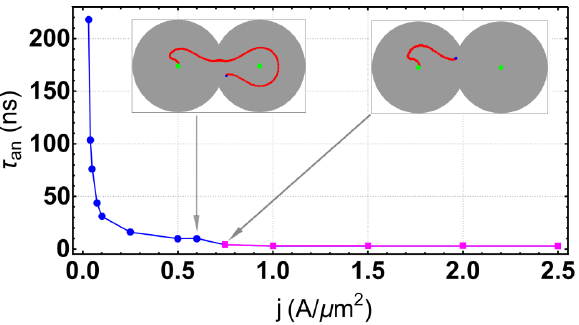
Figure 5. Lifetime of the skyrmion before annihilation as a function of current density J at β = 0.9. The inserts illustrate the annihilation types.